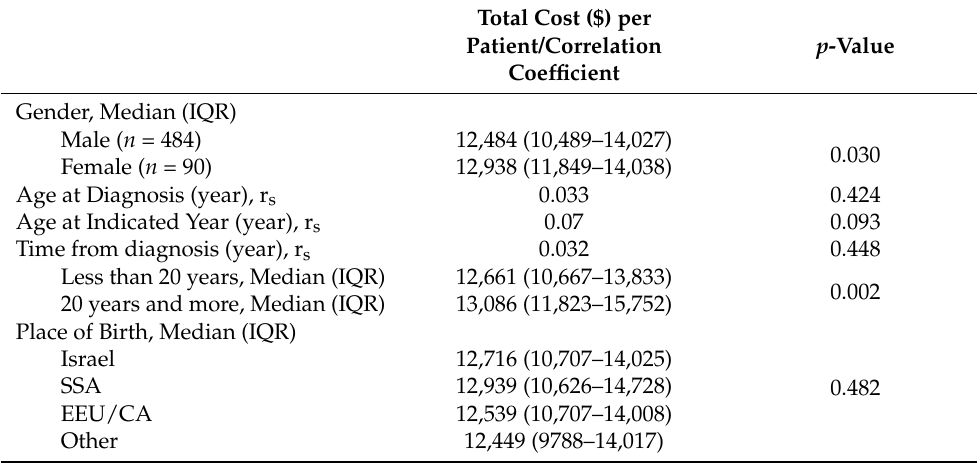
Table 3. Univariate analysis of disease-associated parameters and direct HIV-1